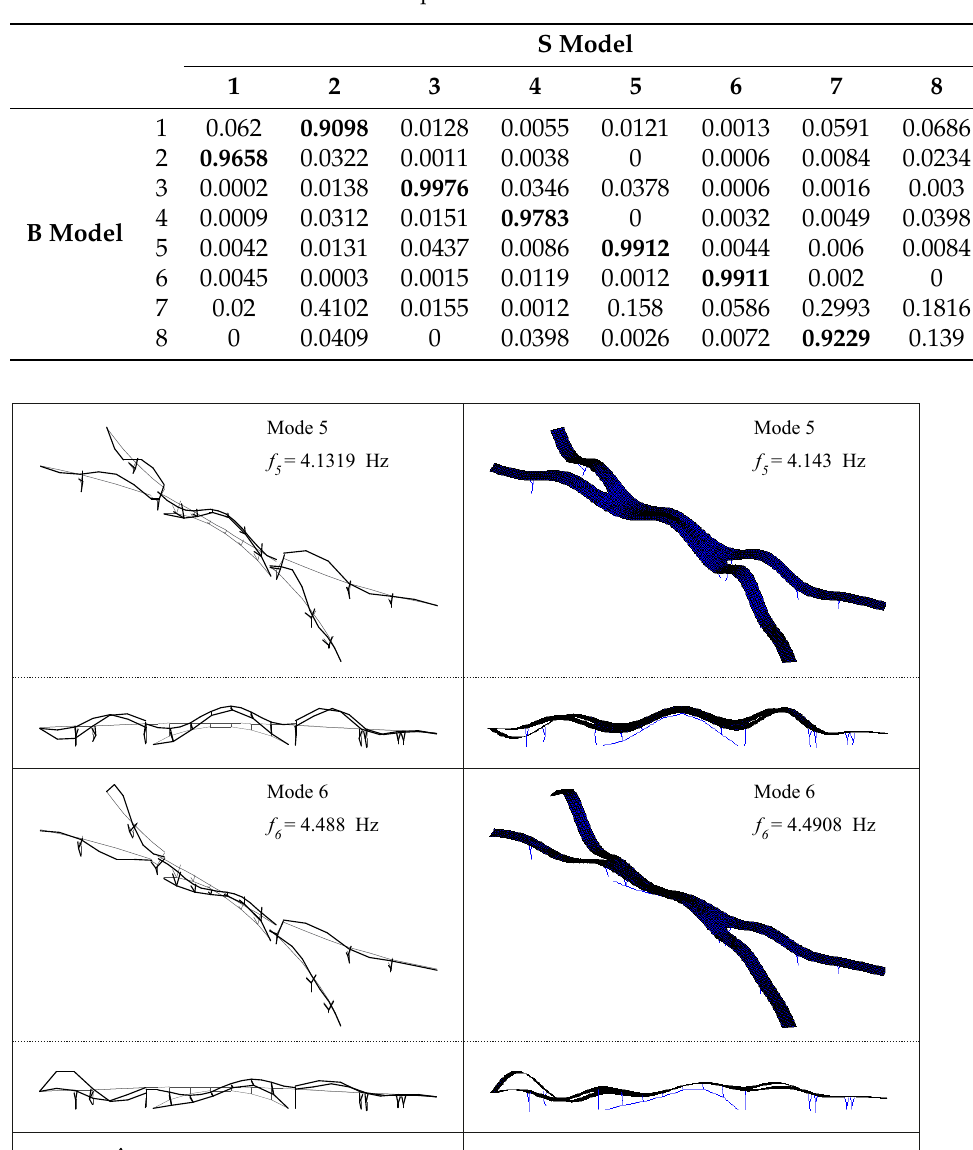
Table 8. MAC between B and S mode shapes.